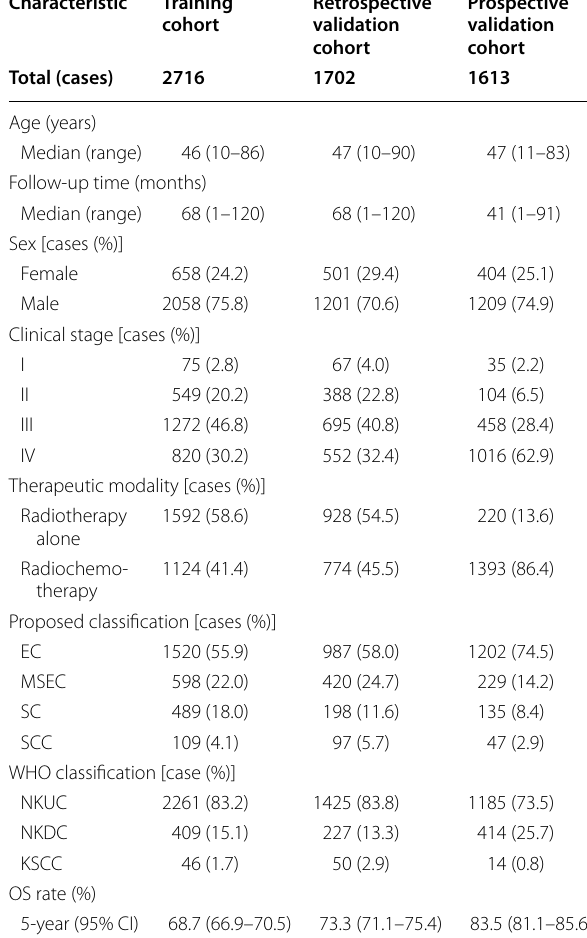
Table 1 Inter-observer reproducibility between two pathologists based on the new nasopharyngeal carcinoma (NPC) histopathologic classification, stratified by area